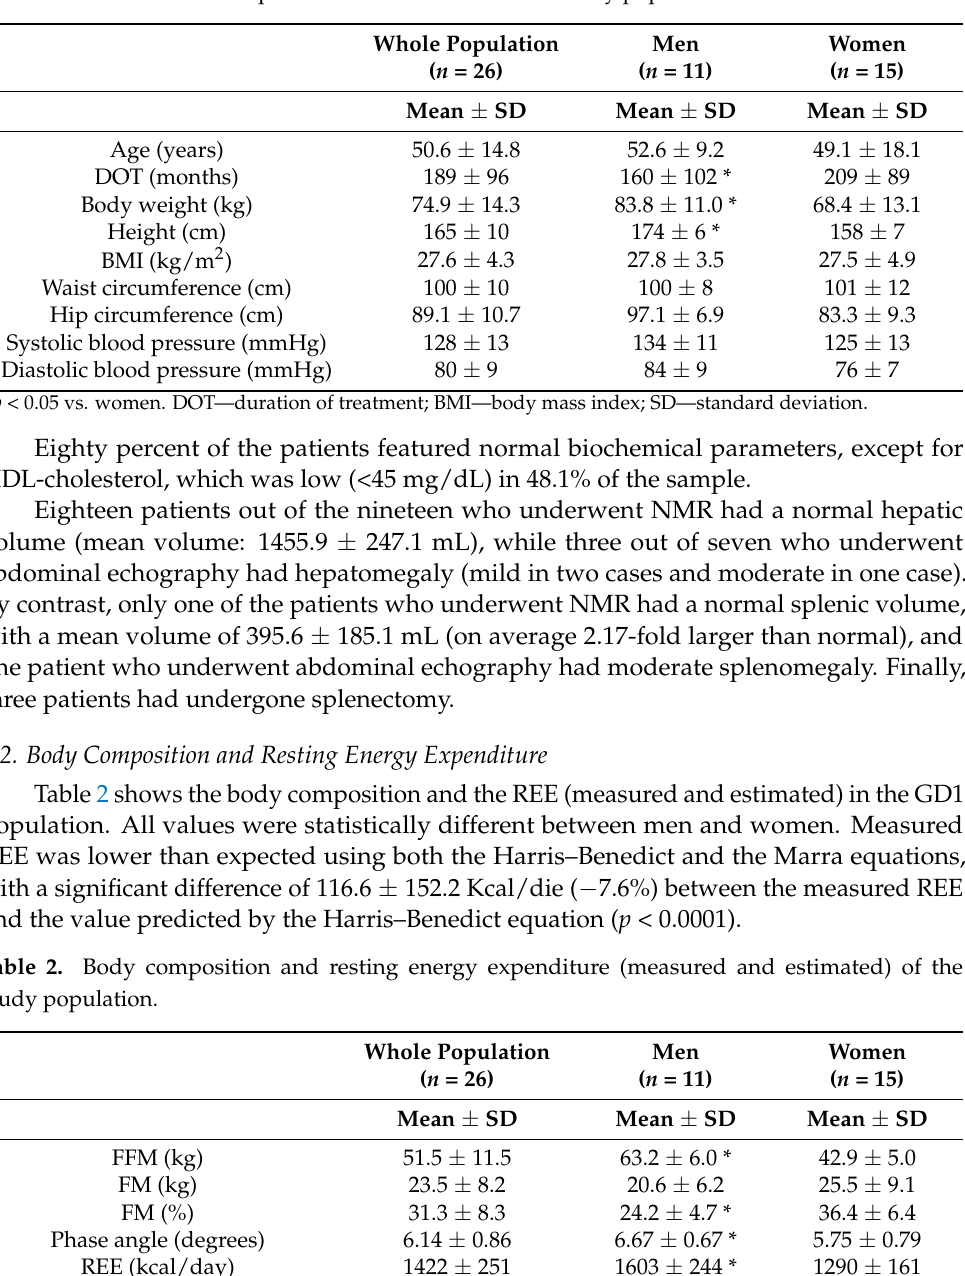
Table 1. General and anthropometric characteristics of the study population.